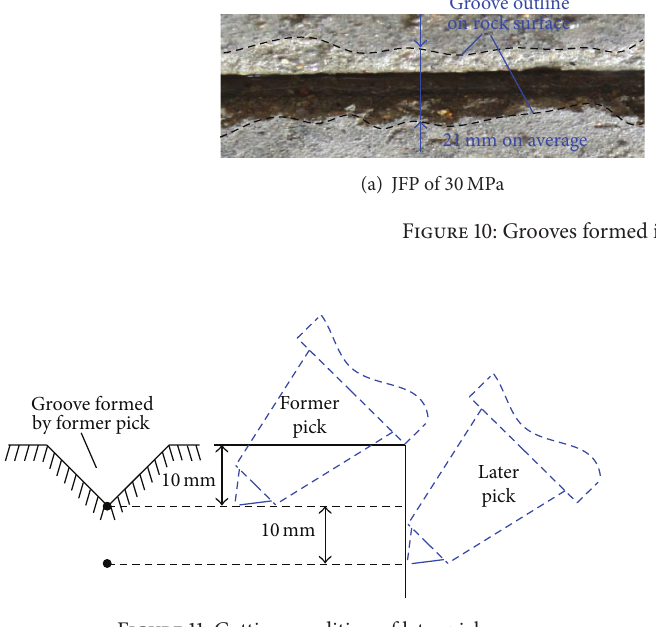
Figure 11: Cutting condition of later pick.